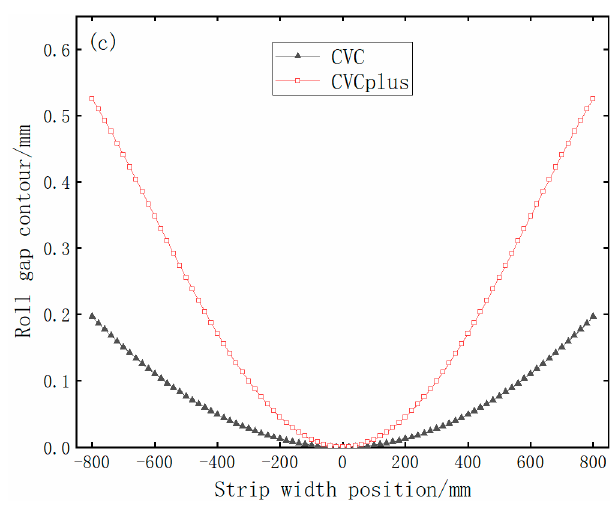
Figure 5. Roll gap contour of CVCplus in different roll shifting positions. ( a ) Roll shifting − 150 mm; ( b ) roll shifting 0 mm; ( c ) roll shifting 150 mm.